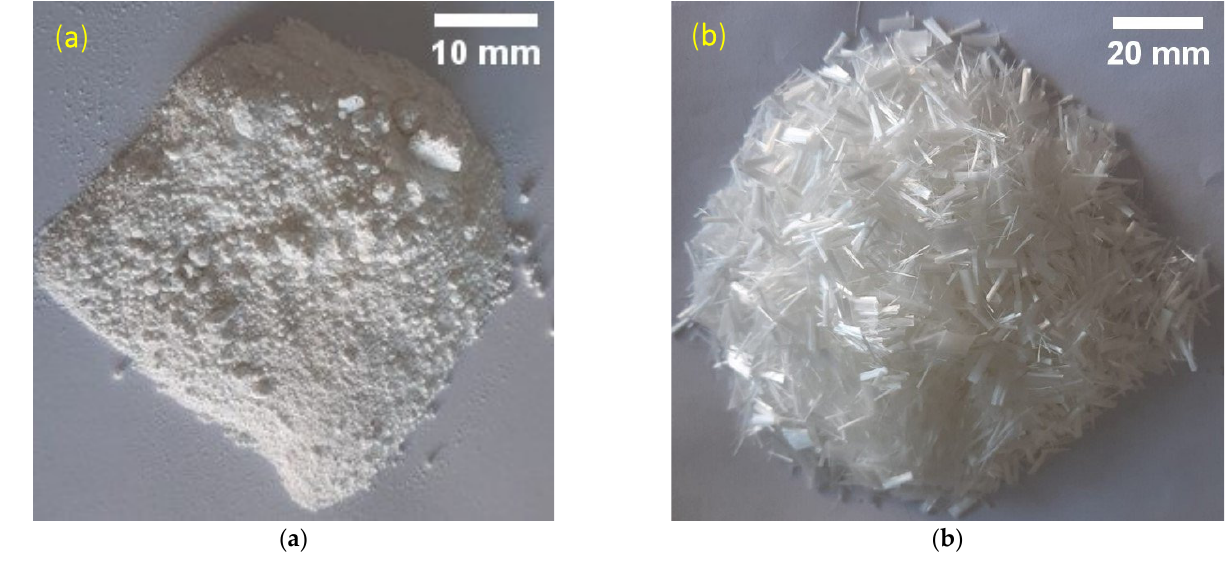
Figure 1. ( a ) Nanocalcite materials ( b ) PVA fiber.